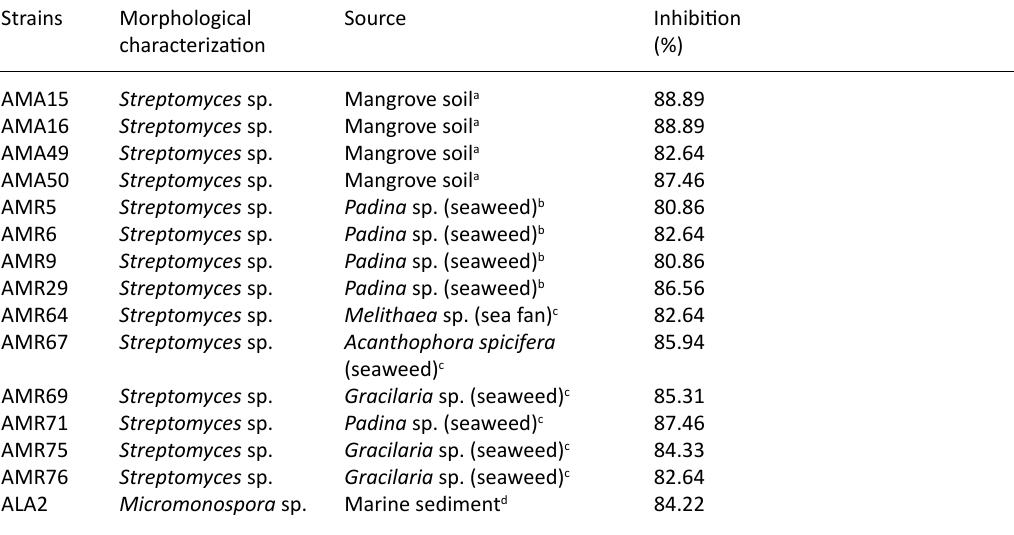
Table 1. The top 15 active actinobacteria strains against hyphal growth of P. oryzae PTRC1 by an agar well diffusion method